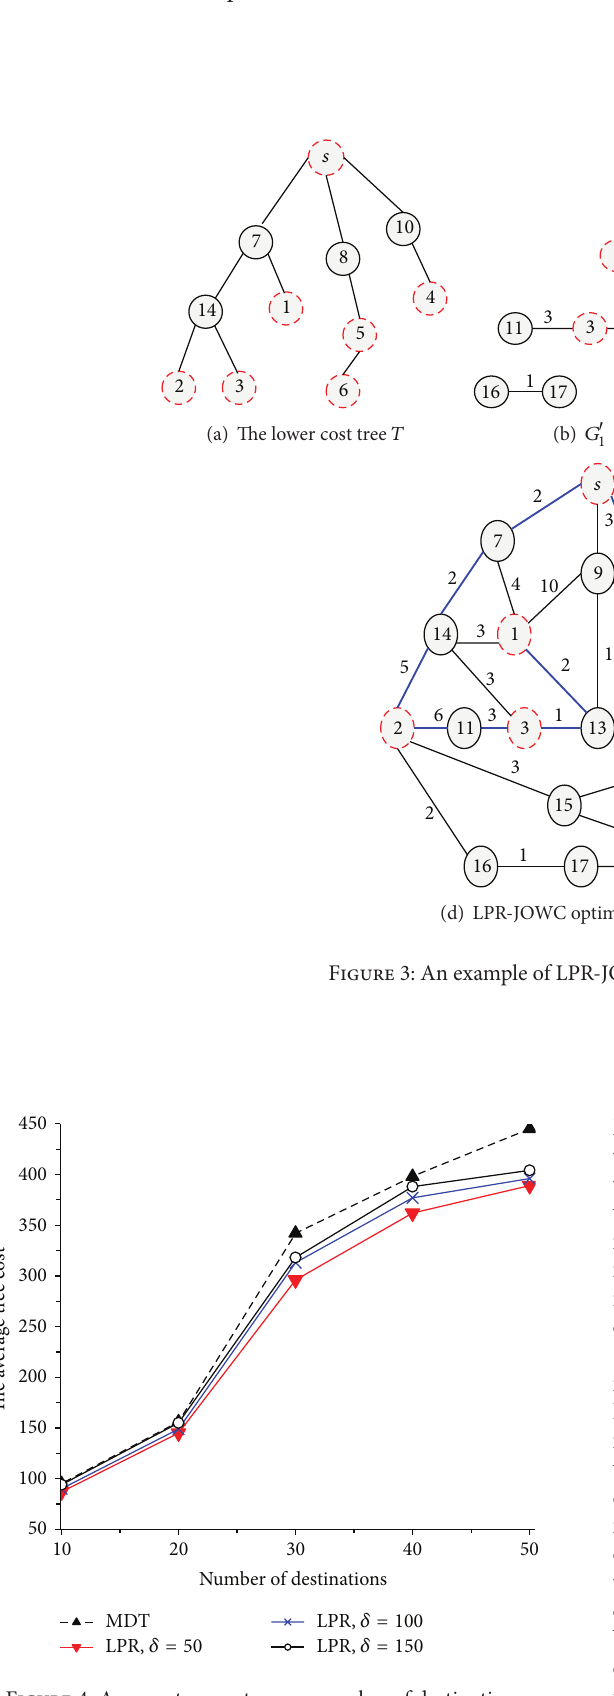
Figure 4: Average tree cost versus number of